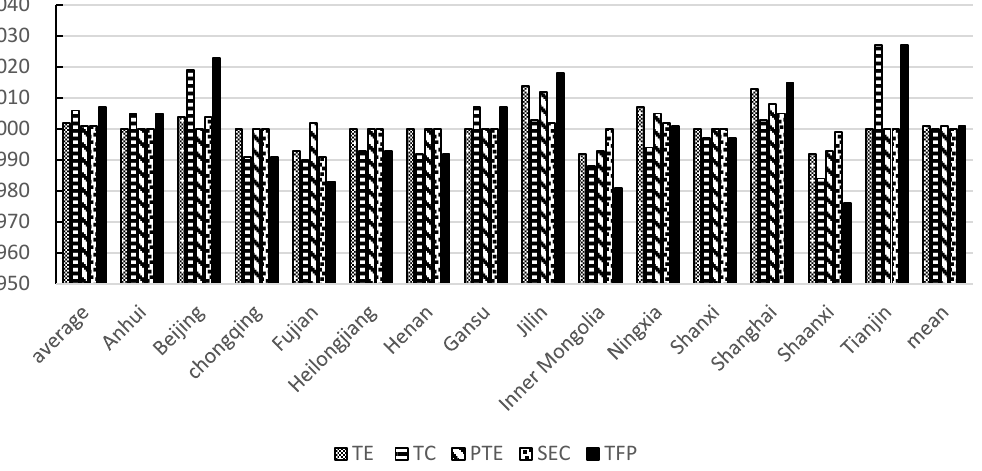
Figure 3. Efficiency changes in medium-scale raw milk production areas in China from 2004 to 2020.